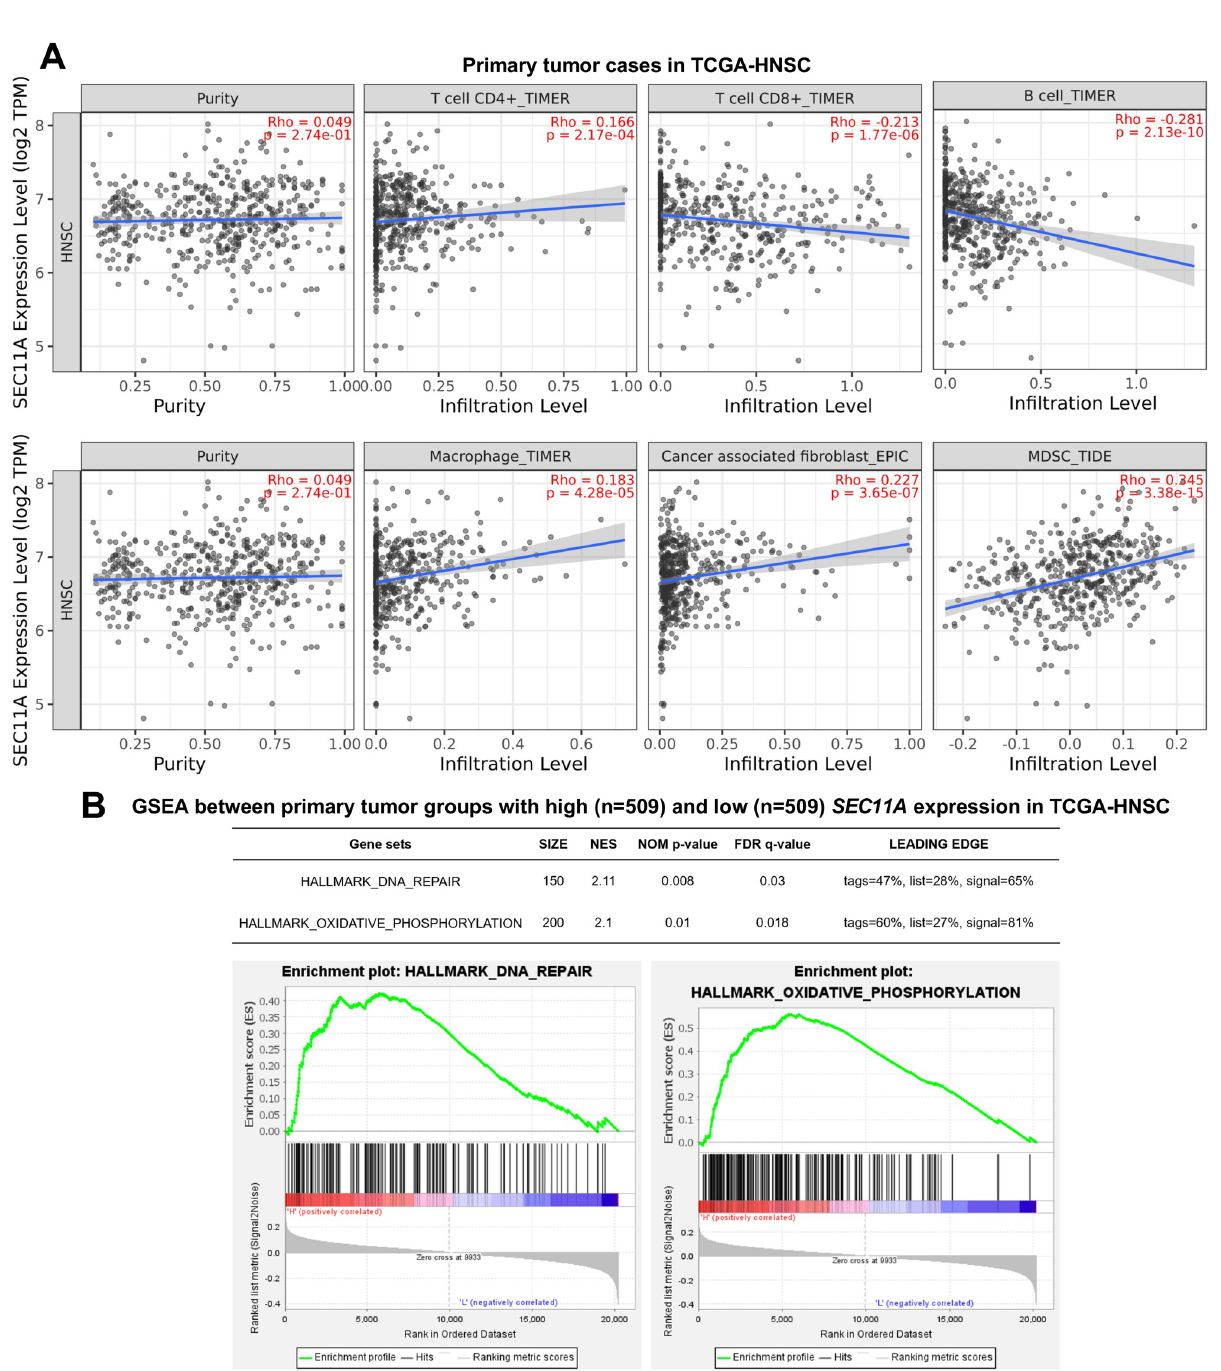
Fig 4. SEC11A expression might predict the infiltration of immune cells in the tumor microenvironment. A. Pearson’s rho values were calculated to assess the correlation between the expression of SEC11A and the infiltration of immune cells in the head and neck squamous cell carcinoma associated tumor microenvironment, including CD4+ T cells, CD8+ T cells, B cells, macrophages, cancer-associated fibroblasts and MDSCs. B. A summary (top) and representative images (bottom) of plot images of the gene sets significantly enriched in the high SEC11A expression group.